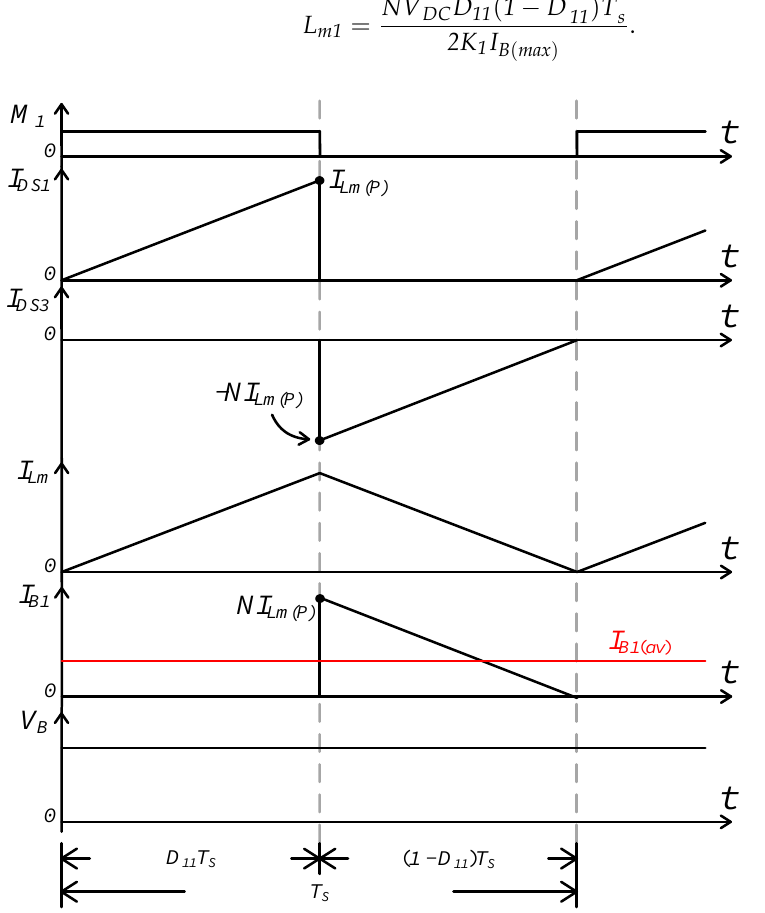
Figure 11. Ideal waveforms of inductor current I Lm and charging current I B1 of the proposed flyback converter operated in the boundary of CCM and DCM.